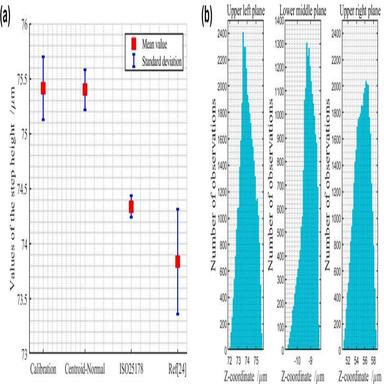
Comparison of results in Experiment 1: (a) Step heights computed by each method; (b) Distribution of the Z-coordinate values of the evaluation planes.